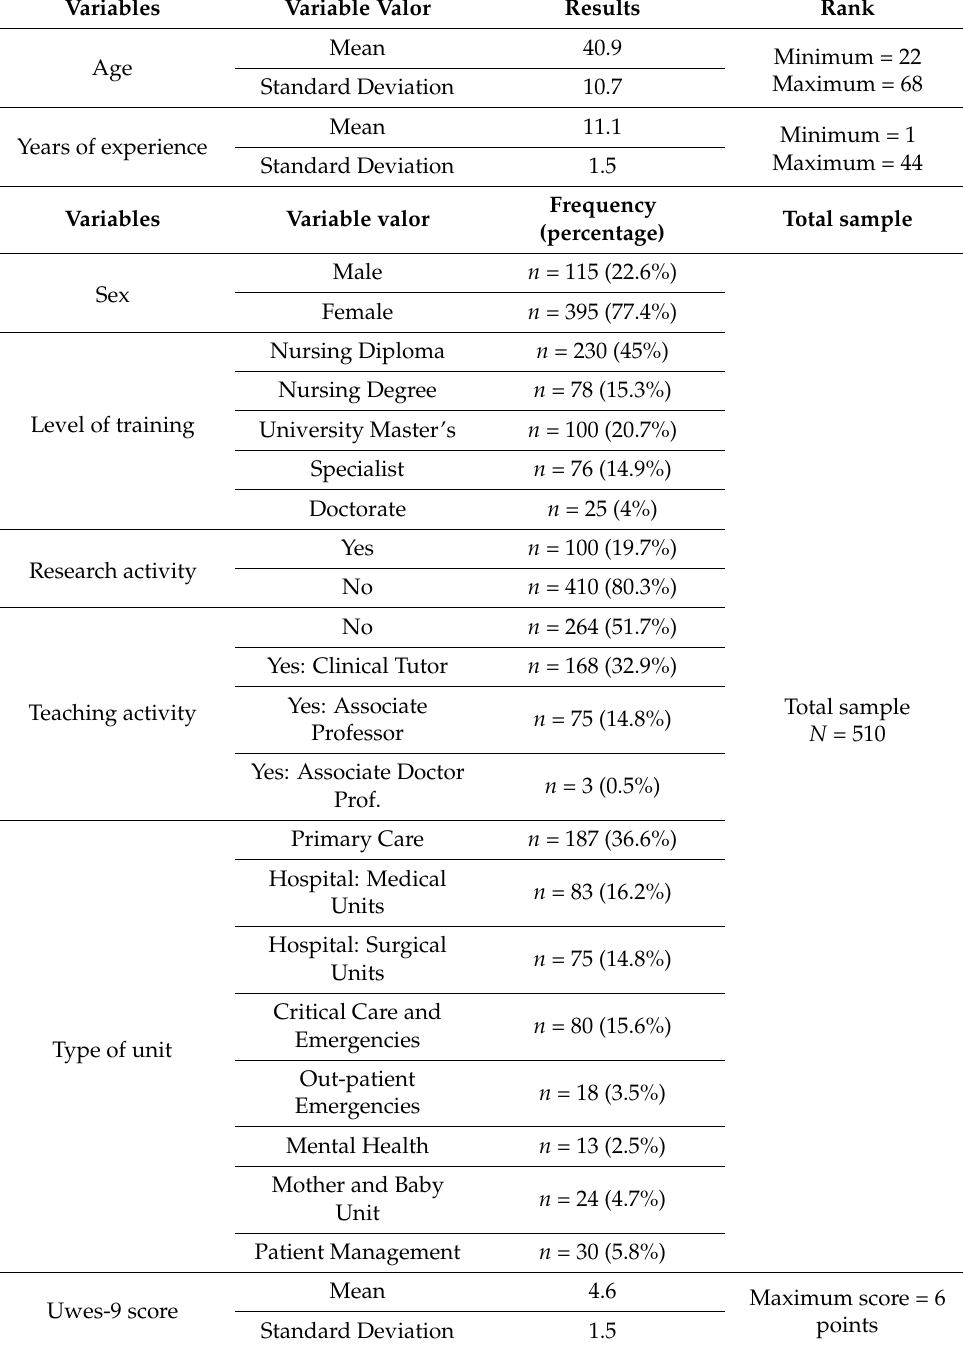
Table 1. Description of the sample